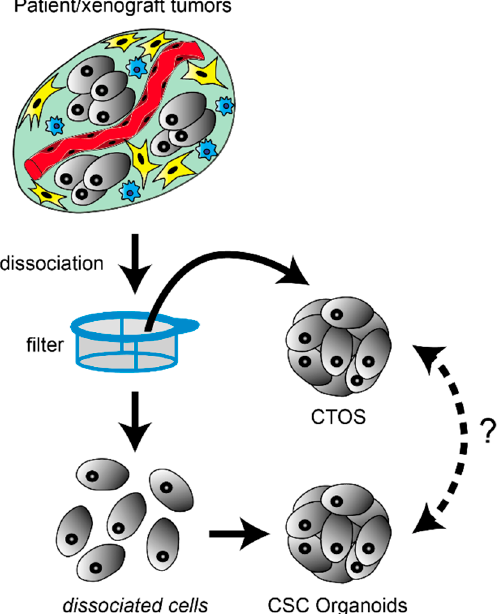
Figure 1. Preparation of cancer stem-like cell (CSC)-derived organoids and cancer tissue-originated spheroids (CTOSs). In both methods, tumor specimens are mechanically and enzymatically digested. To generate CSC-derived organoids, tumor tissues are dispersed at the single-cell level, and organoid formation occurs by either re-aggregation or clonal proliferation. Optionally, incompletely dissociated fragments trapped by filters are further trypsinized to recover more single cells. In contrast, to generate CTOSs, tumor tissues are incompletely digested into fragments on purpose by milder conditions. These cell clusters rapidly form spherical-shaped CTOSs within 24 h. Because the cell-cell contact is retained during the preparation process, CTOS could better recover heterogenous cells including those at non-CSC state by avoiding anoikis, On the other hand, CSC-derived organoids could better enrich the cells with cancer-stem like property. However, it remains an open question whether the cells obtained by these different methods are interchangeable or not.